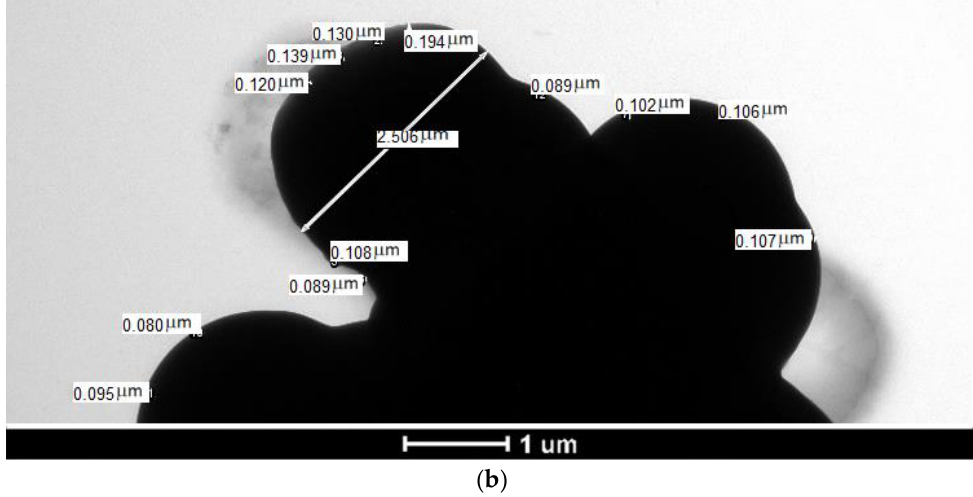
Figure 8. Trial-3 microcapsule TEM images at scales of ( a ) 500 nm and ( b ) 1µm.